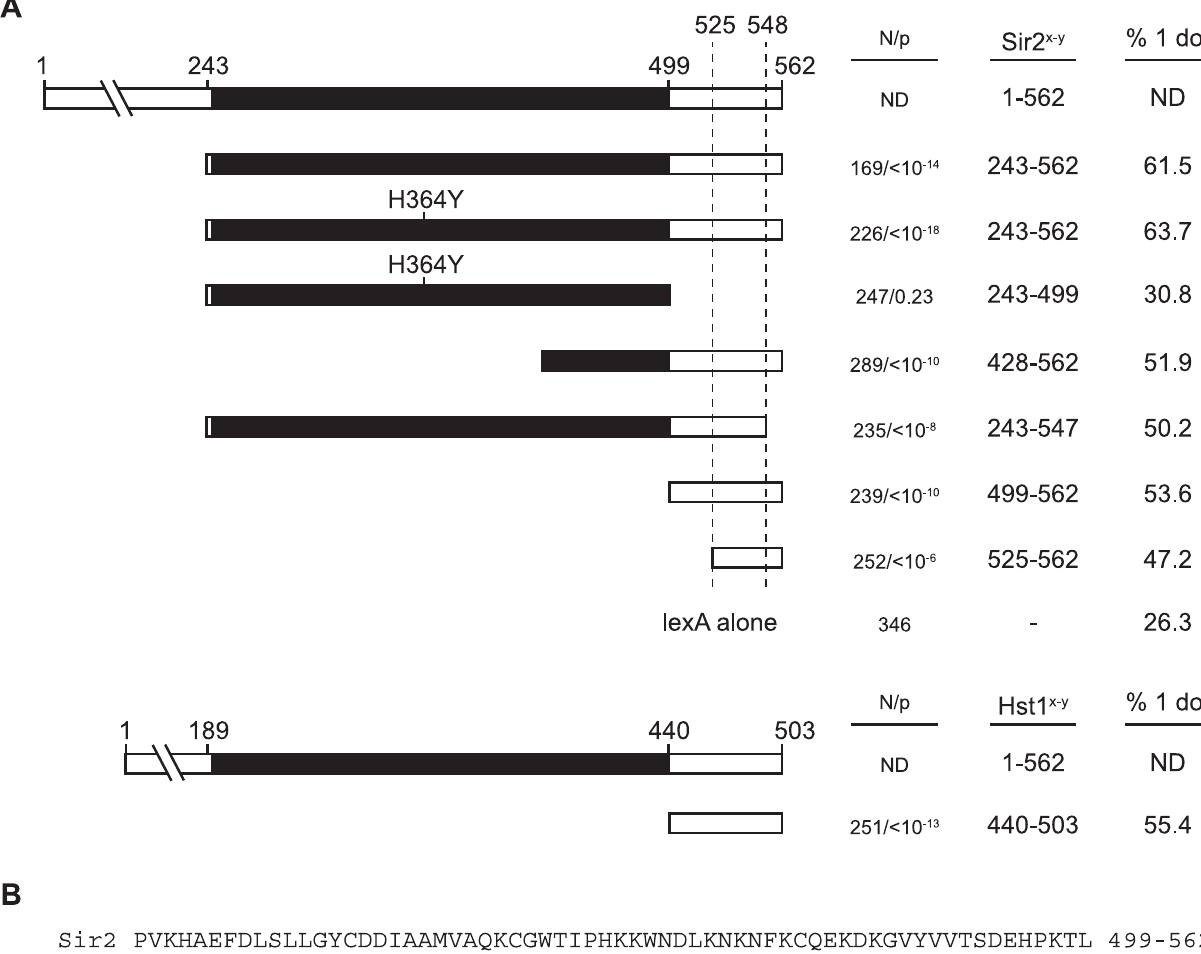
Figure 4. A non-catalytic domain of Sir2 mediates cohesion. A ) Cohesion assays with Sir2 fragments. A map Sir2 shows the conserved catalytic core domain in black. Strain CSW42 ( D sir2 ) was transformed with vectors expressing lexA-Sir2 243–562 (pCSW1), lexA-Sir2 243–562(H364Y) (pCSW3), lexA-Sir2 243–499(H364Y) (pCSW56), lexA-Sir2 428–562 (pCSW6), lexA 243–547 (pCSW10), lexA-Sir2 499–562 (pYFC1), lexA-Sir2 525–562 (pYFC2), lexA-Hst1 440–503 (pYFC6) or lexA alone (pCSW2). Immunoblotting with antibodies to lexA confirmed that the cohesion-deficient chimera lexA-Sir2 243–499(H364Y) expressed appropriately (data not shown). ND = not determined. B ) Alignment of the Sir2 499–562 and Hst1 440–503 with conservation noted according to CLUSTALW criteria [78]: identical residues (*); conservative substitutions (:); semi-conservative substitutions